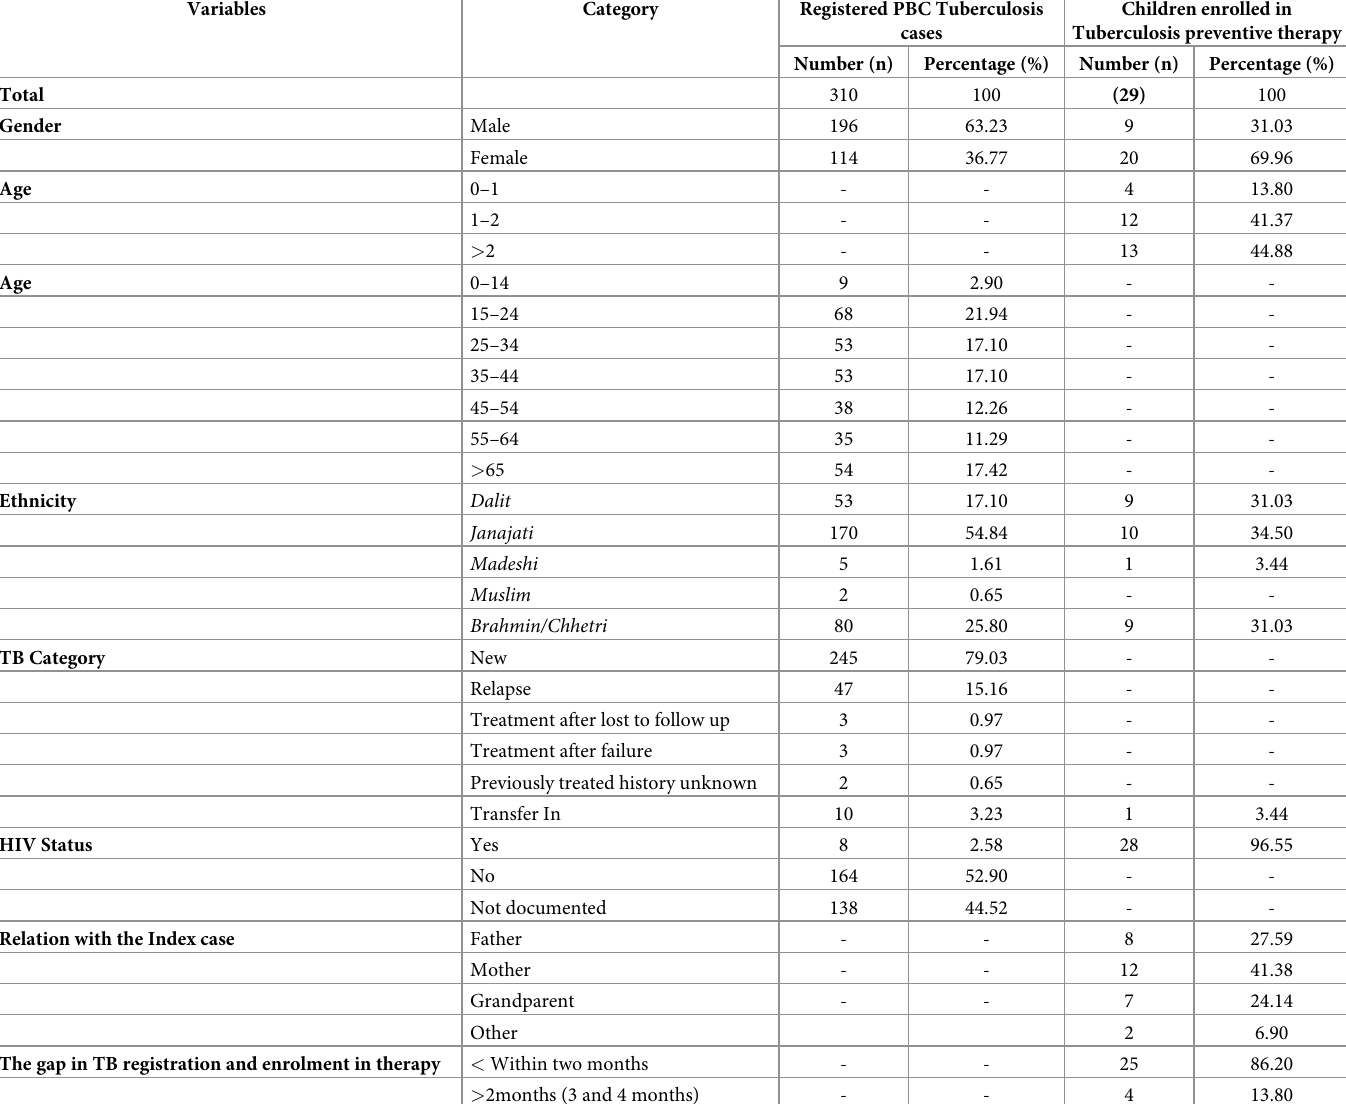
Table 1. Sociodemographic and clinical profile of PBC tuberculosis and children enrolled in TBPT Kaski district. Variables